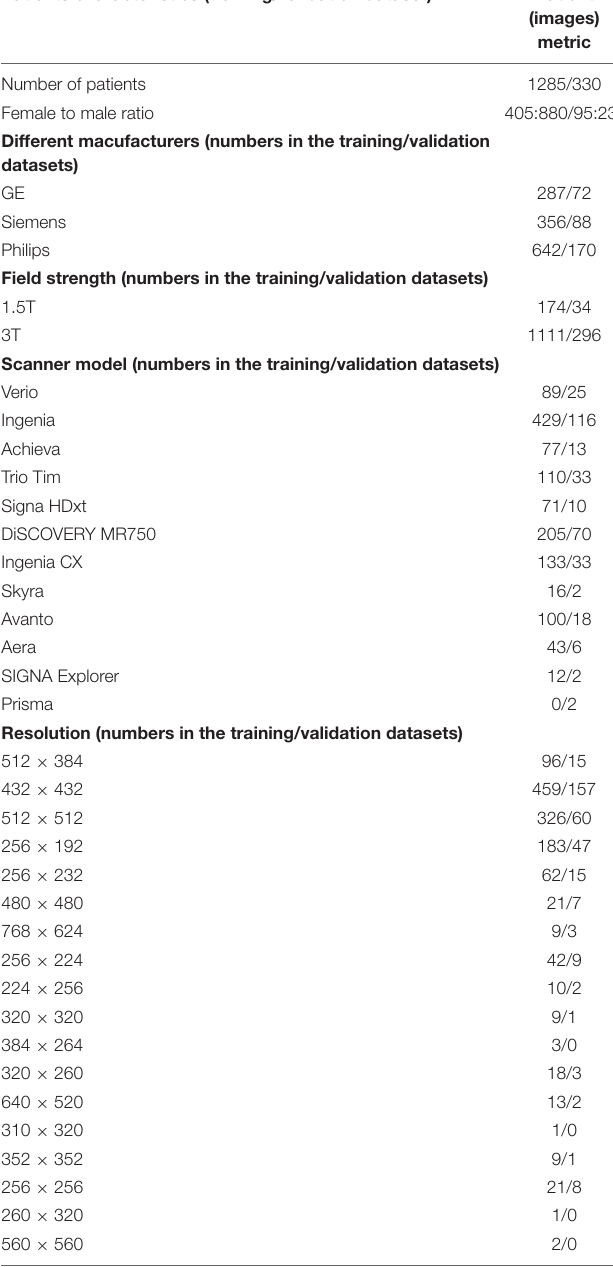
TABLE 1 | Basic information of the patients, manufacturers, and parameters of scanners. Patients characteristics (training/validation